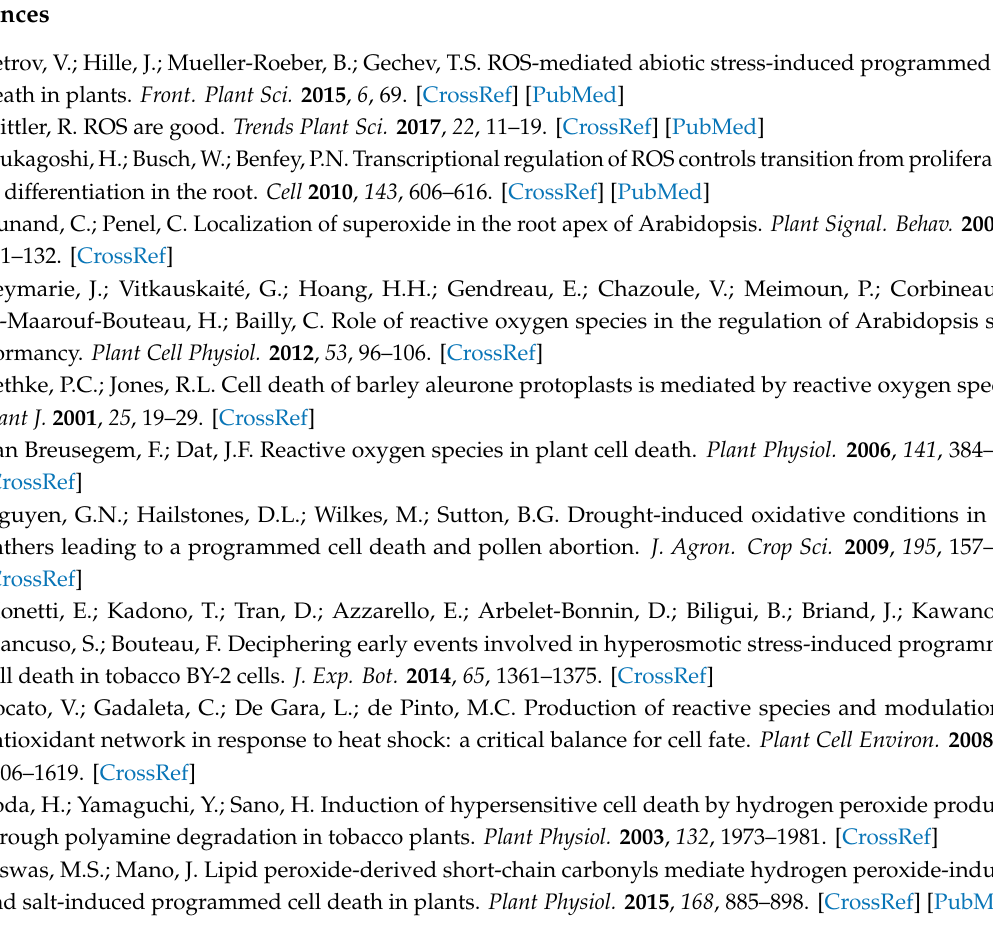
Figure S1. Acrolein-induced cell death was suppressed by the C3LP inhibitor. Four-d cultured BY-2 cells were treated with 0.2 mM acrolein or 0.2 mM acrolein + 20 µ M of each inhibitor (C1LP or C3LP) and harvested after 5 h. (A) Typical fluorescence photographs (top row) and phase contrast microscopy of the same images (bottom): (i) untreated cells as control, (ii) 0.2 mM acrolein, (iii) 0.2 mM acrolein + 20 µ M C3LP inhibitor, (iv) 0.2 mM acrolein + 20 µ M C1LP inhibitor (top). White arrows indicate dead cells. (B) FDA-staining cells were counted for living cells and expressed as percentage. The data are the mean ± SE. Di ff erent letters represent significant di ff erent data ( p < 0.05 on Tukey test). Figure S2: Typical chromatograms of DNP-carbonyls in BY-2 cells. The cells were treated with water as control (A) and H 2 O 2 (B). Four-d-cultured cells treated with H 2 O 2 at 1 mM and incubation for 10 min. The identified aldehydes are labelled at the top of each peak. Figure S3. Activation of C3LP in BY-2 cells after exposure to acetaldehyde. Four-d cultured cells were treated with various concentration of acetaldehyde as indicated. Protease inhibitors were added to cell extracts to a final concentration of 0.1 mM and caspase assay was performed as described in Materials and Methods. Statistical di ff erences compared to controls are indicated by asterisks. ( p < 0.05, Student’s t